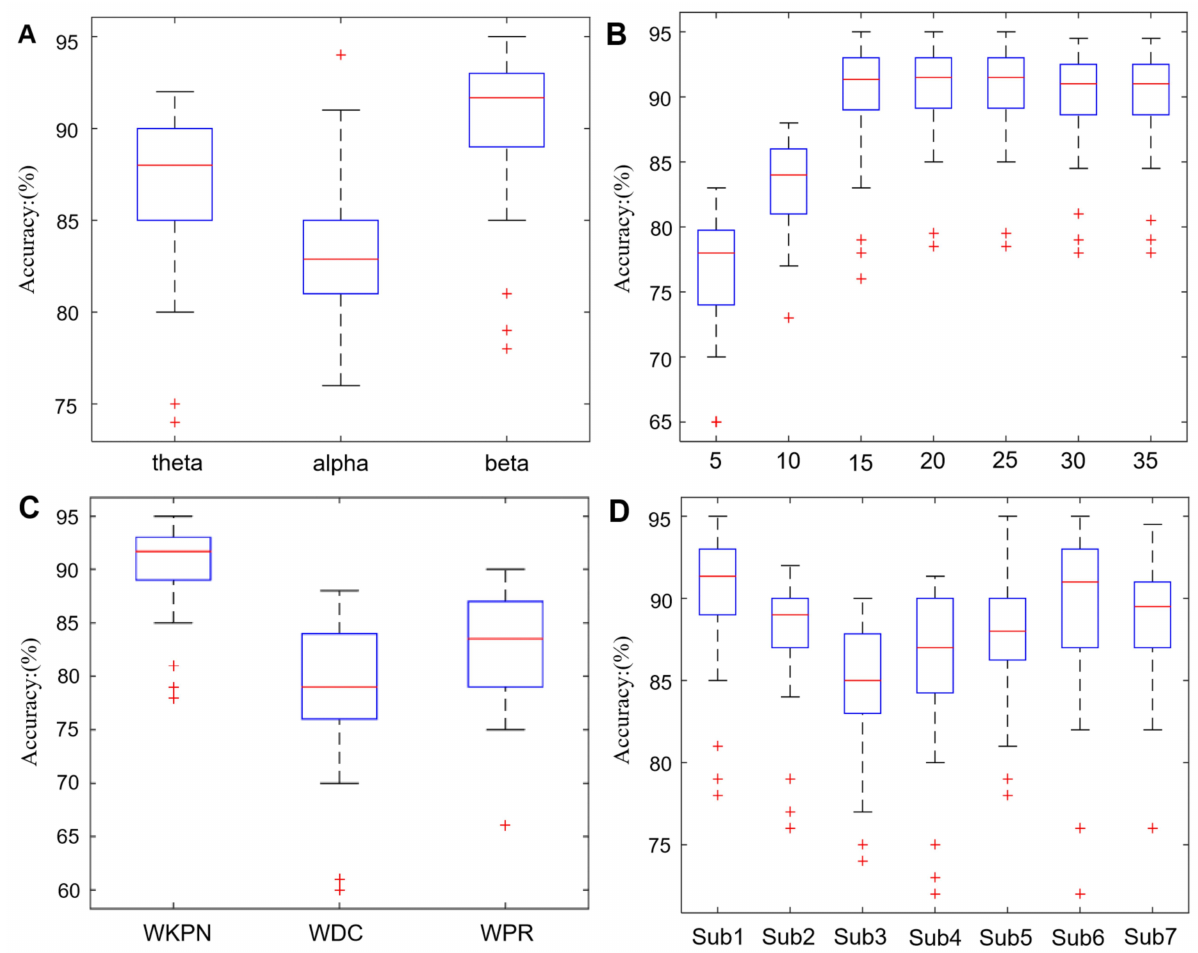
Figure 6. The classification accuracy rate. ( A ) The classification accuracy results of three bands. The classification accuracy is range from 80% to 92% in theta band, 72–91% in alpha band, and 85–95% in beta band. The highest mean classification accuracy is 92% achieved in beta band. ( B ) The beta band classification accuracy with different length feature vector. ( C ) Comparison of classification accuracy between WKPN, WDC, and WPR algorithm. ( D ) Classification accuracy differences between subjects in the beta band. Each ‘+’ stands for one outlier result of this